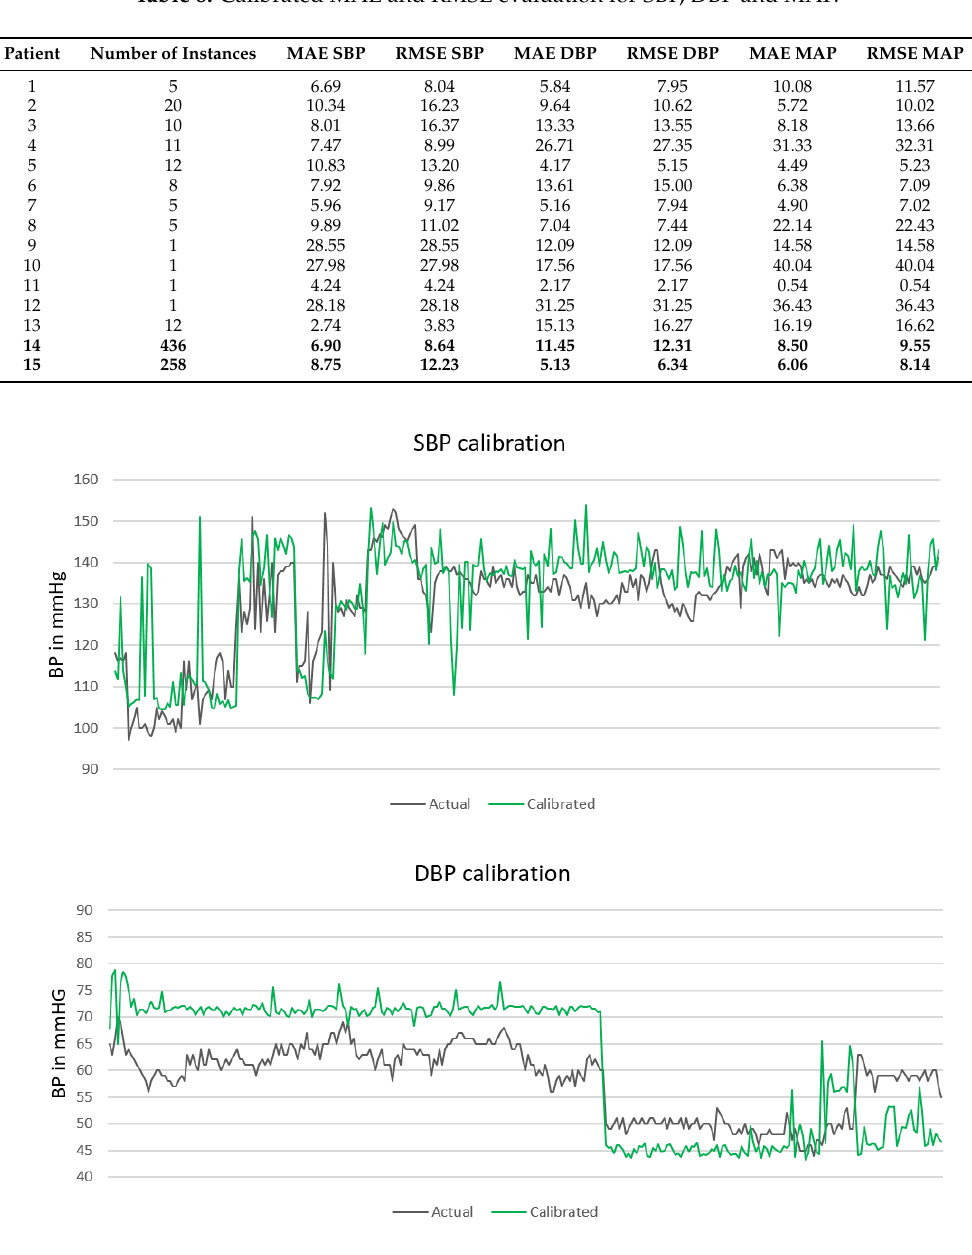
Figure 3. SBP and DBP calibration for testing